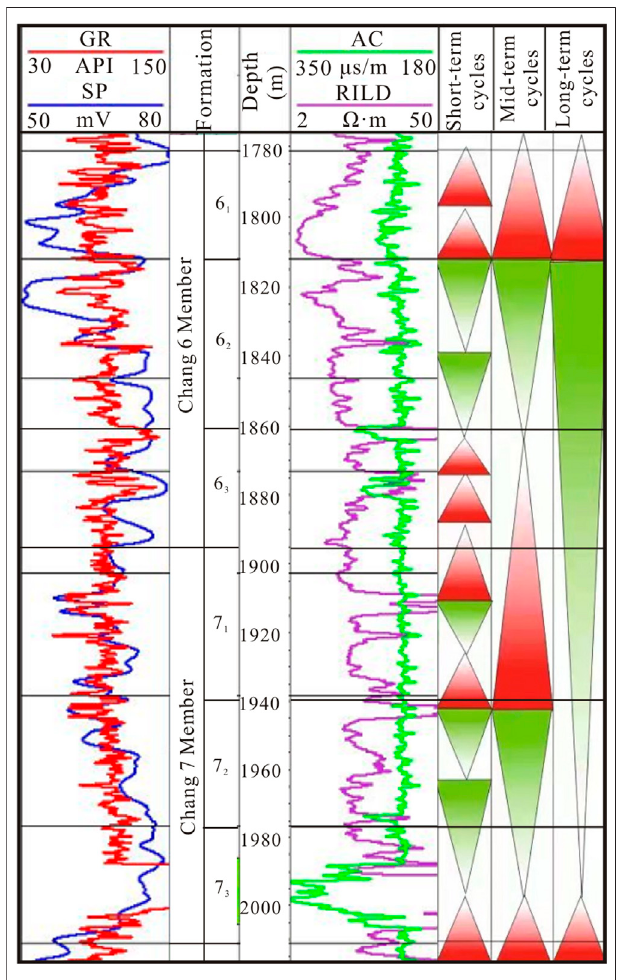
FIGURE 2 | Sedimentary characteristics of Chang 6 and Chang 7 Members of the Upper Triassic Yanchang Formation in Well Z1. GR — natural gamma; SP spontaneous potential; AC — longitudinal wave time difference; RILD —